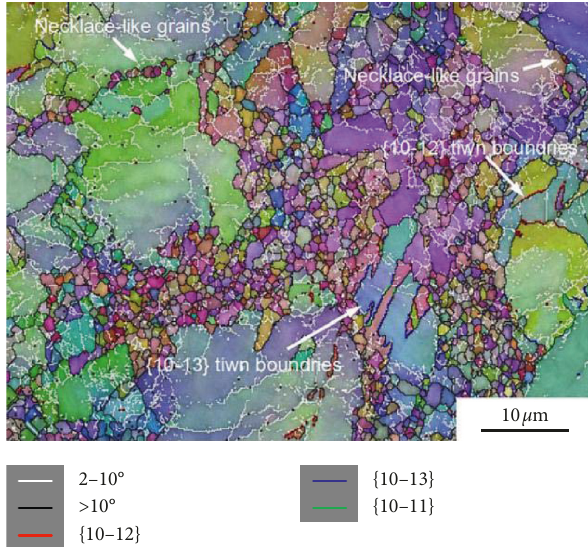
Figure 7: Orientation map of the samples after two-pass